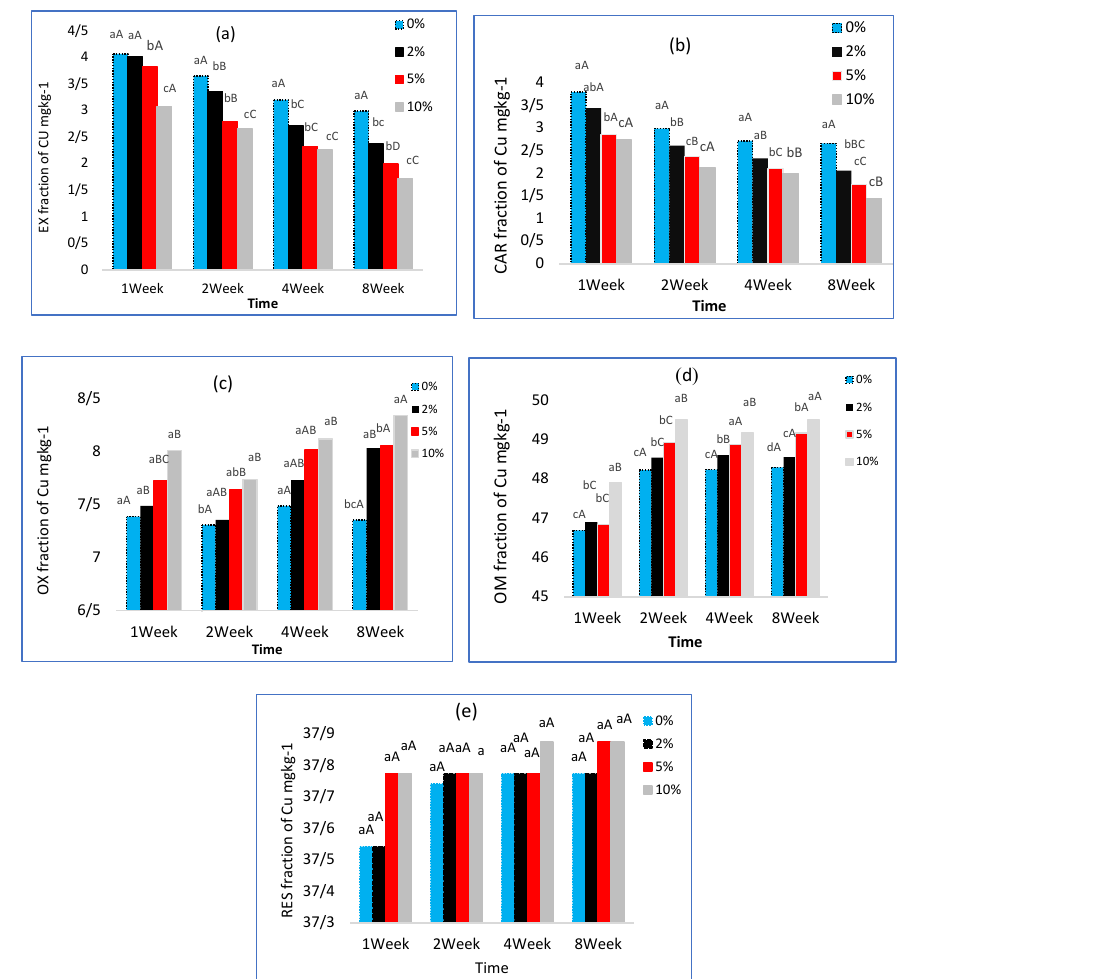
Figure 4. (a) The Exchangeable (EX) fraction, (b) Carbonate (CAR) fraction, (c) Oxides (OX) fraction, (d) Organic Matter (OM) fraction and (e) Residual (RES) fraction. Small letters indicate the effect of different CW biochar rates on chemical forms on Cu, and capital letters indicate the effect of biochar on different incubation